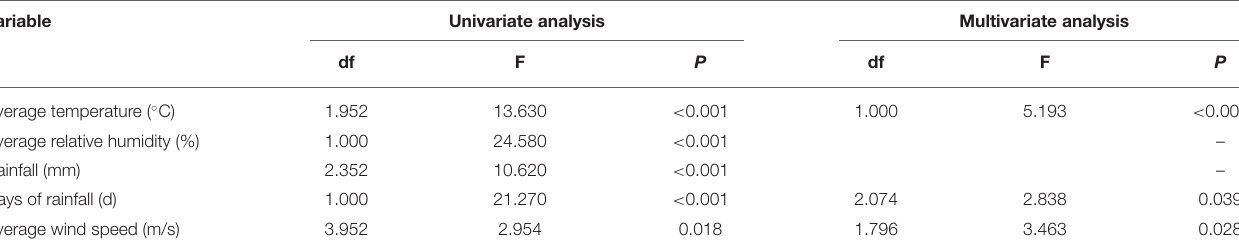
TABLE 1 | HPIV-3 detection rate according to meteorological factors using the generalized additive model (GAM). Variable Univariate